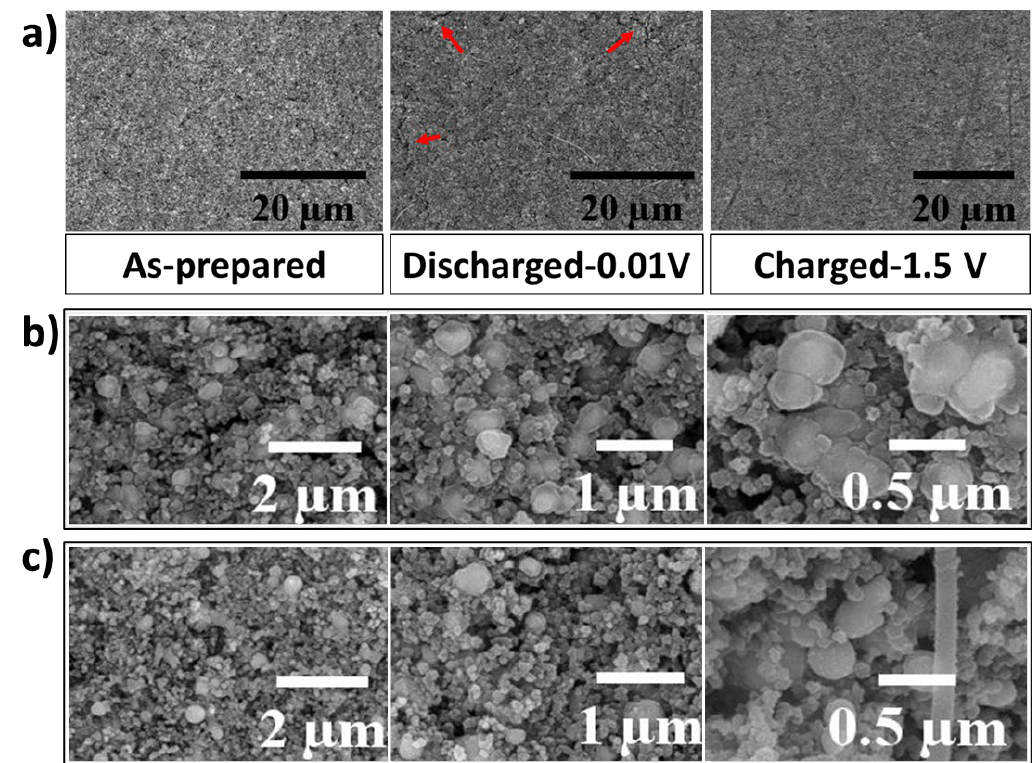
Figure 5. ( a ) Low magnification ex-situ SEM images of as-prepared, discharged (to 0.01 V vs. Li/Li + ), and charged (to 1.5 V vs. Li/Li + ) EGaInSn LMNP electrodes, ( b ) high magnification ex-situ SEM images of fully discharged, and ( c ) fully charged electrodes. The charging and discharging of the electrodes were conducted at a current density of 0.1 A g –1 .